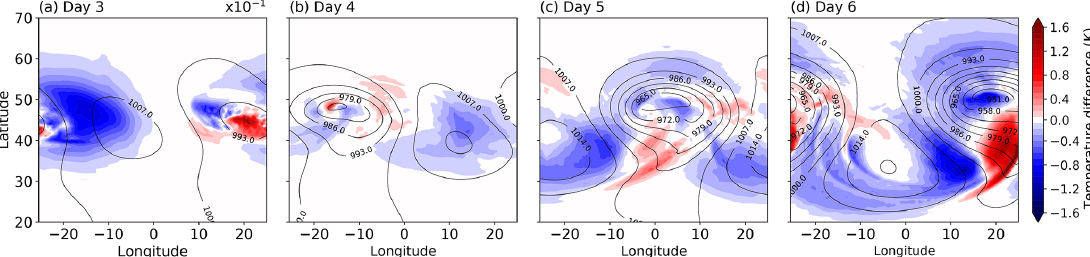
Figure 13. Temperature change due to cloud-radiative heating derived as the mass-weighted vertical average over the depth of the tropo- sphere. The change is calculated as the temperature in the CRH simulation minus the REF simulation. Note that the scale of the temperature change at day 3 is 10 times smaller than for the other days.